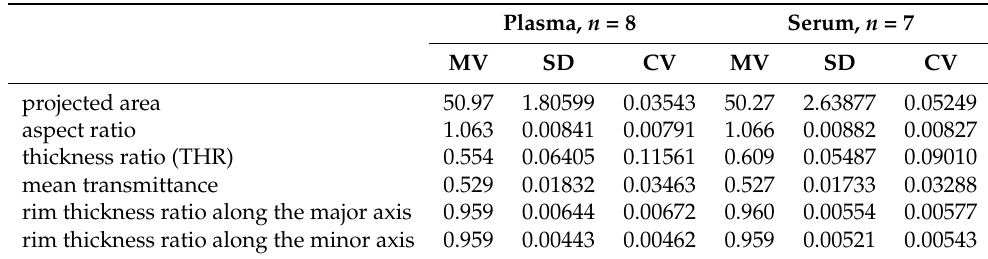
Figure 3. Sections along the major (long) and minor (wide) axis through an RBC with median values (Table 1) of THR and aspect ratio. The vertical black lines indicate the edges of the digitized shape (Figure 2b). The red line is a spline through the GVs (blue circles). The vertical green lines are auxiliary lines for the determination of the local maximum of the red line and the two minima at its left and right hand side. These three values are indicated by horizontal orange lines. Table 1. Mean values (MV), standard deviations (SD), and coefficients of variation (CV = MV/SD) of the medians of the distributions 1 to 6. Results for RBCs suspended in plasma and